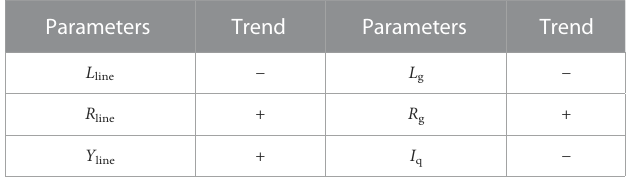
TABLE 3 VARIATION TREND OF PARAMETERS AND U PCC